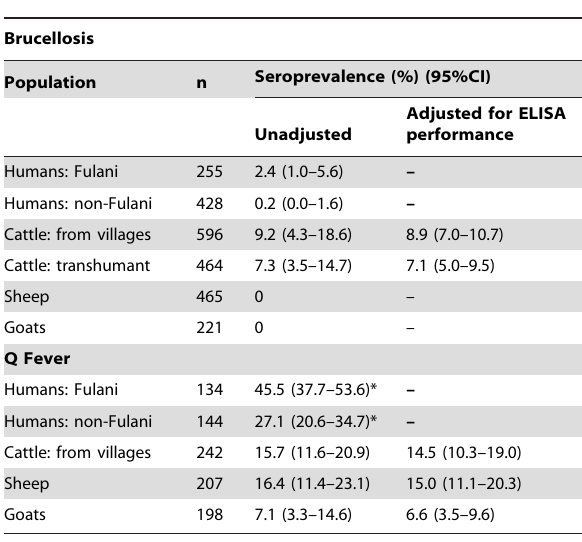
Table 2. Seroprevalence of brucellosis ( Brucella spp) and Q Fever ( Coxiella burnetii) in people and